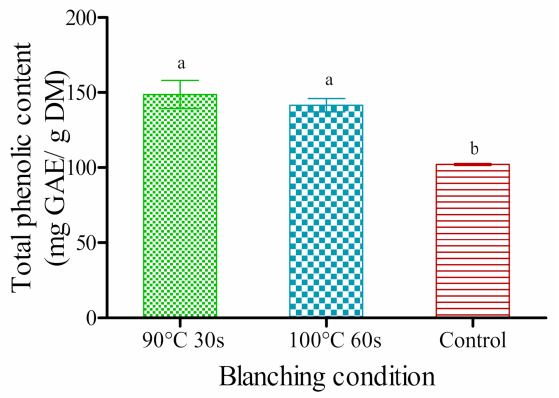
Figure 3. Total phenolic content of dried pomegranate arils cv. Wonderful at different blanching conditions (mg GAE/g DM). (Data presented as means ± SE. Bars followed by different letter(s) are significantly different ( p < 0.05) according to Fisher’s LSD).